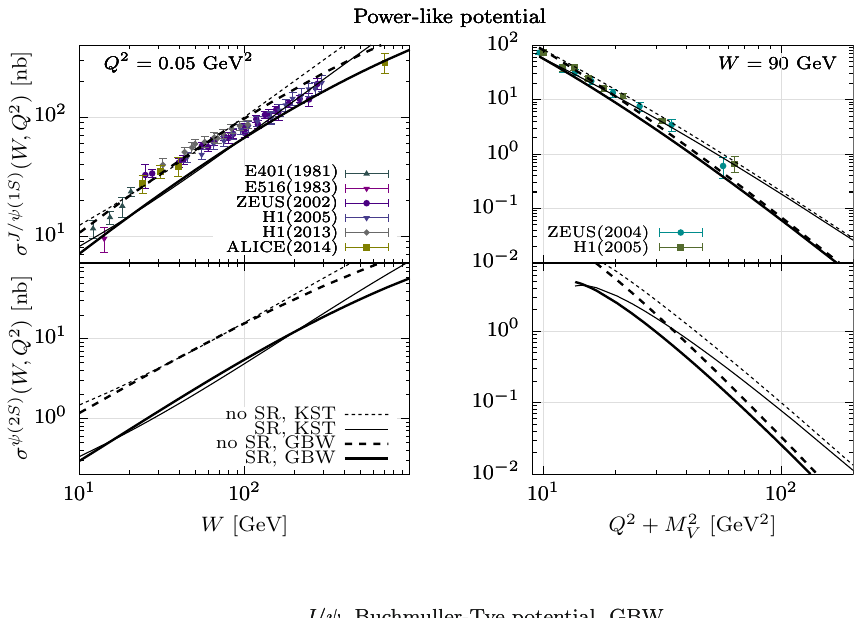
Fig. 3 Relative impact of the D -wave and Melosh spin transform on charmonium production from a comparison of scenarios I, II, III and III noSR (i.e. “ S -wave only” case but without Melosh transform): electroproduction cross section for J /ψ( 1 S ) (upper panels) and ψ (cid:4) ( 2 S ) -to- J /ψ( 1 S ) ratio of electroproduction cross sections (lower panels). Solid lines represent the ratio (I–III noSR )/III noSR , dashed lines: (I–III)/III, and dotted lines: (II–III)/III. The results have been obtained using GBW [38] dipole parameterisation and with the wave functions of J /ψ( 1 S ) and ψ (cid:4) ( 2 S ) mesons generated by the BT potential